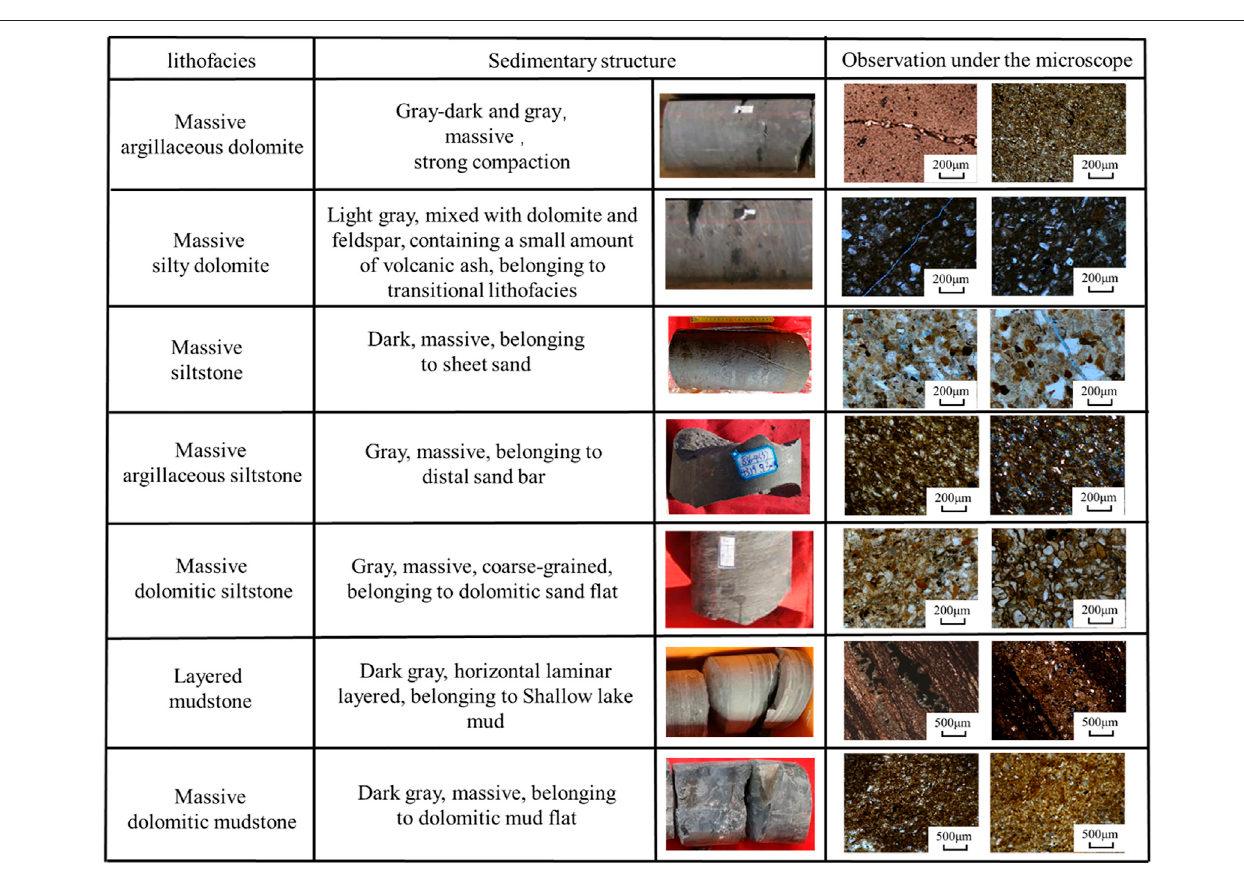
FIGURE 5 | Comparison of lithofacies